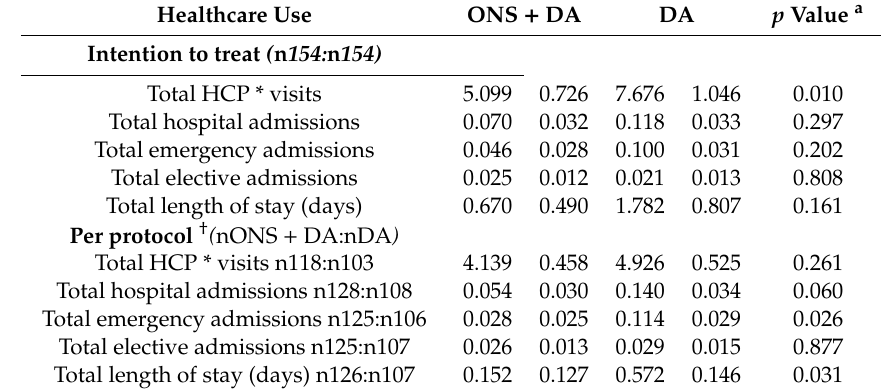
Table 4. Average health care use per subject during the 12-week intervention period according to type of intervention and analysis (intention to treat and per